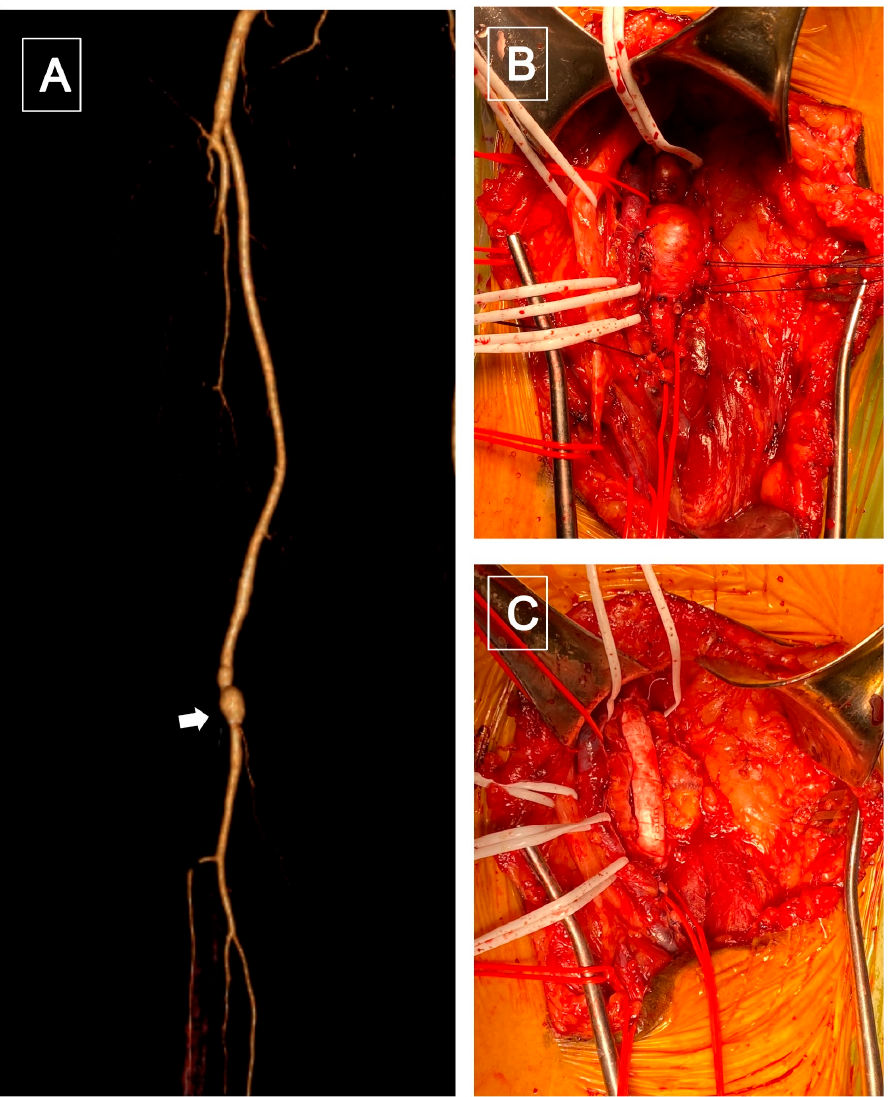
Figure 1. ( A ), CTA volume rendering reconstruction showed a popliteal (P2) saccular aneurysm (white arrowhead). ( B ) Intraoperative: popliteal aneurysm exposure using a posterior surgical access. ( C ) Popliteal reconstruction with a bypass using a 7 mm polytetrafluoroethylene (PTFE) graft.